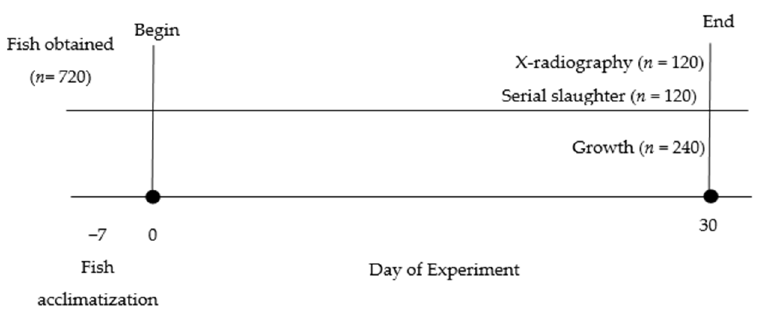
Figure 1. Experiment timeline, where groupers were obtained and acclimatized for 7 days (Day 7), before being distributed to the experimental tank on Day 0. Groupers were distributed evenly among four treatment groups (28, 30, 32, and 34 ◦ C) and among 3 tanks within each group, for a total of 12 tanks. Groupers were cultured for 30 days before growth was measured. Overall, 5 groupers from each tank were removed for X-radiography (5 fish × 3 replicates × 4 temperatures × 2 diets = 120) and serial slaughter experiment (5 fish × 3 replicates × 4 temperatures × 2 diets = 120) while 10 groupers (10 fish × 3 replicates × 4 temperatures × 2 diets = 240) were obtained from each tank for the growth